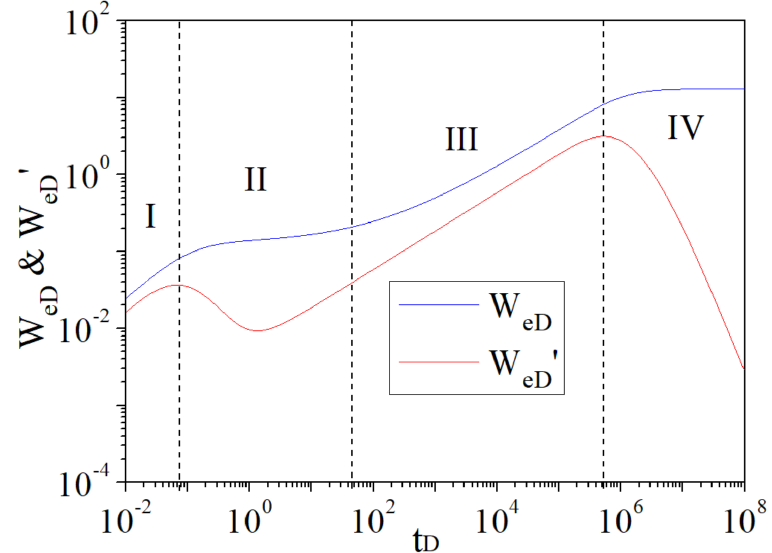
Figure 2. Dimensionless water influx characteristic curves of a naturally fractured edge water gas